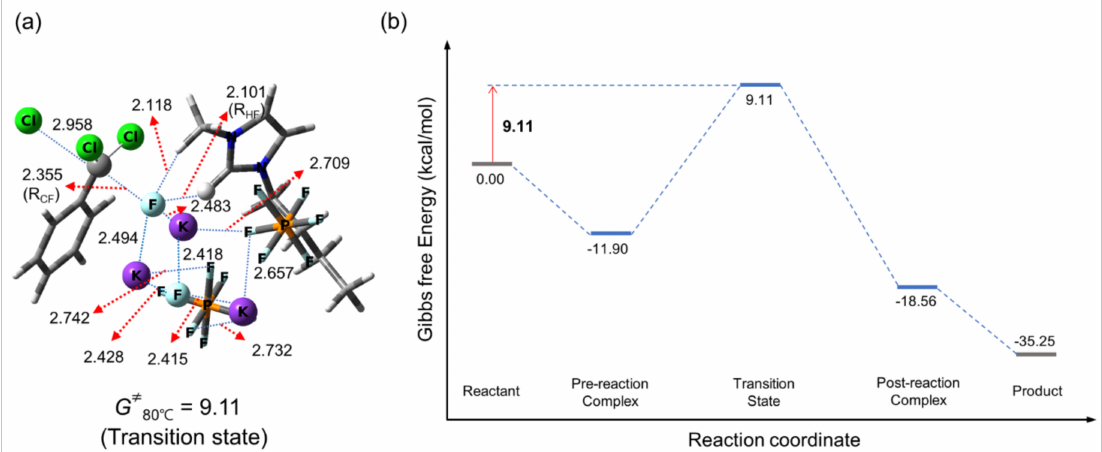
Figure 6. Calculated ( a ) transition state and ( b ) energetics of S N 2 fluorination in [bmim]PF 6 with substrate: KF:KPF 6 =